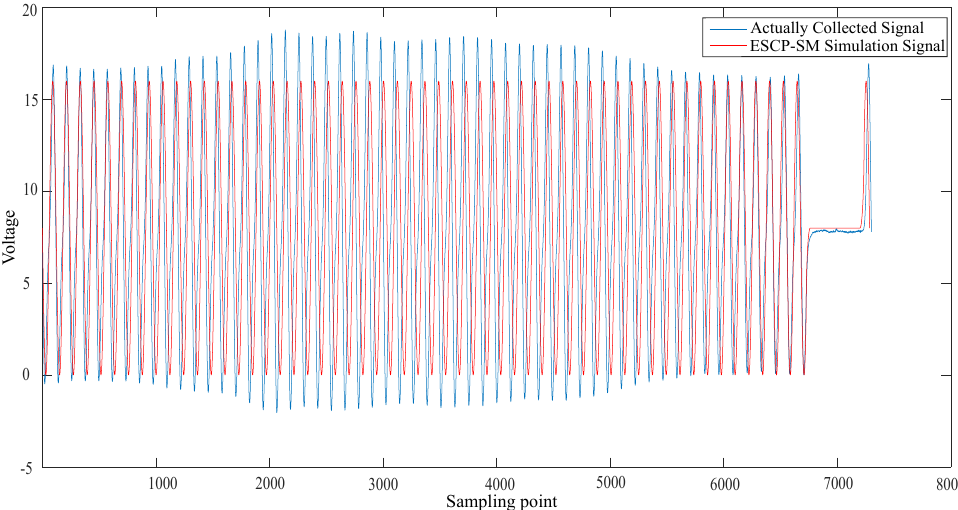
Figure 18. Comparison of the ESCP-SM simulation and actually collected signal. In Figure 19, the blue curve represents the actually collected CKP signal. The red curve represents the HBS-EED simulation CKP signal. In the HBS-EED simulation, the CKP signal vibration is large, and the signal amplitude fluctuates wildly.